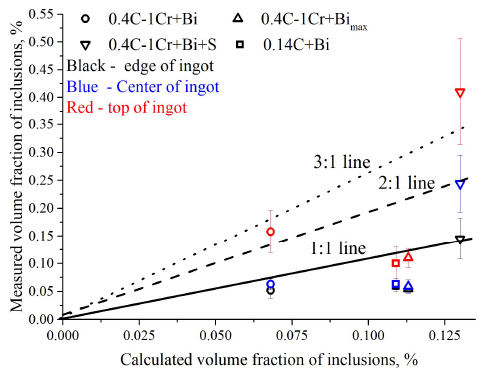
Figure 9. Comparison of calculation and measurement results.